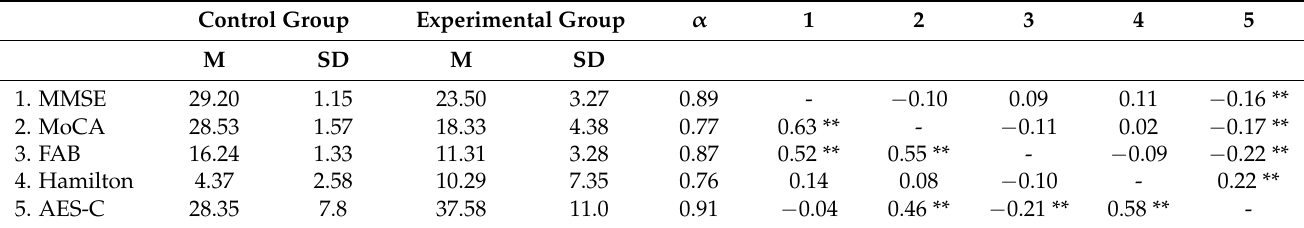
Table 4. Descriptive statistics and inter-correlations (N = 214) a